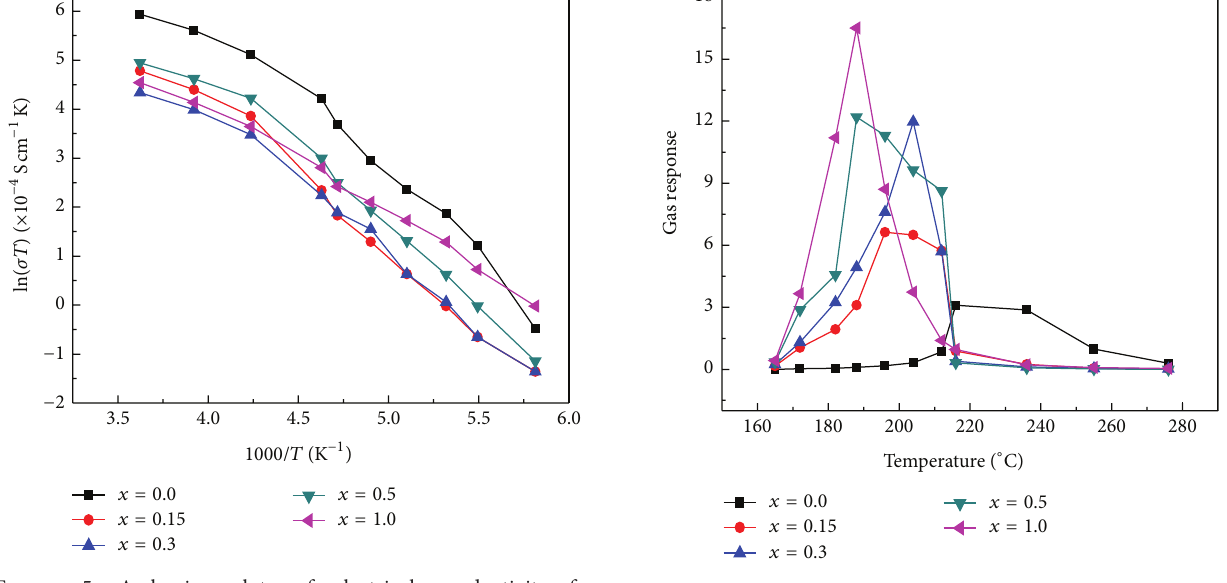
Figure 7: Temperature dependence of the response in 0.25 mg/L ethanol of La 1−𝑥 Nd 𝑥 FeO 3 sensors.